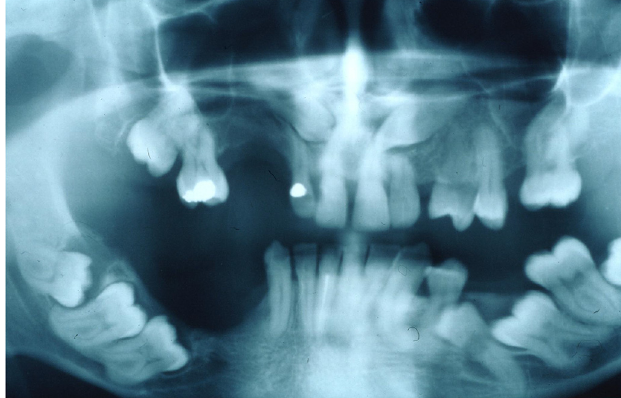
Fig. 3. Panoramic radiography of patient A during his treatment (age: 16